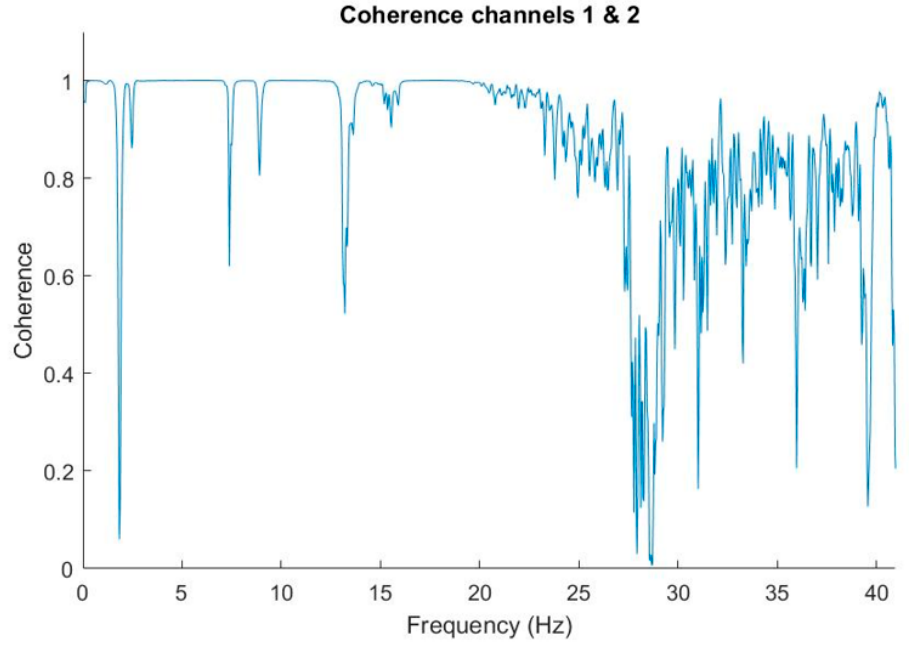
Figure 13. Coherence analysis between channels 1 and 2.